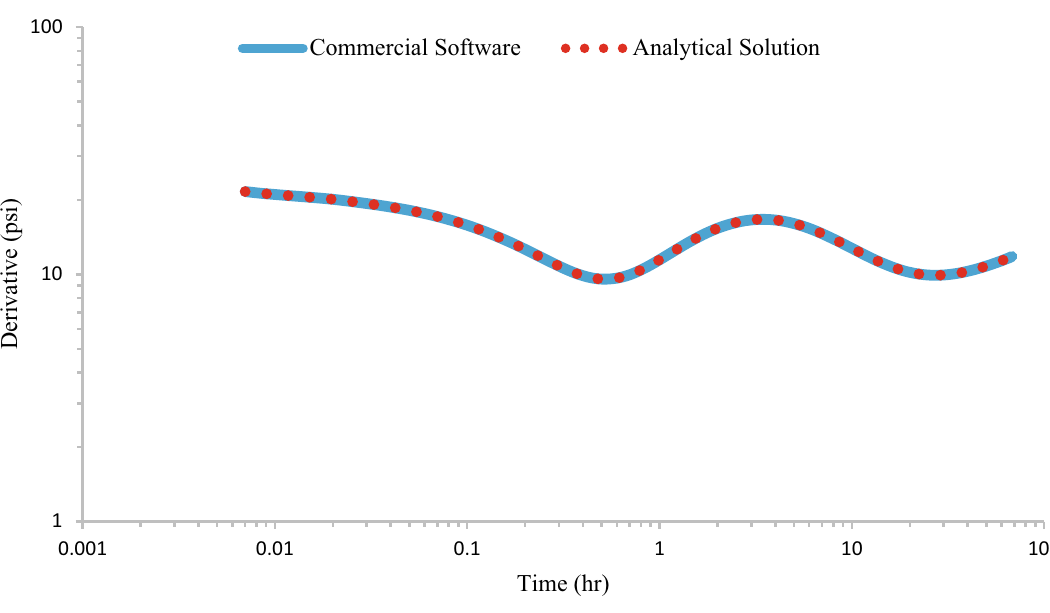
Fig. 12 Matching analytical and numerical pressure derivative plots in log–log scale of the scenario No. 4 in naturally fractured